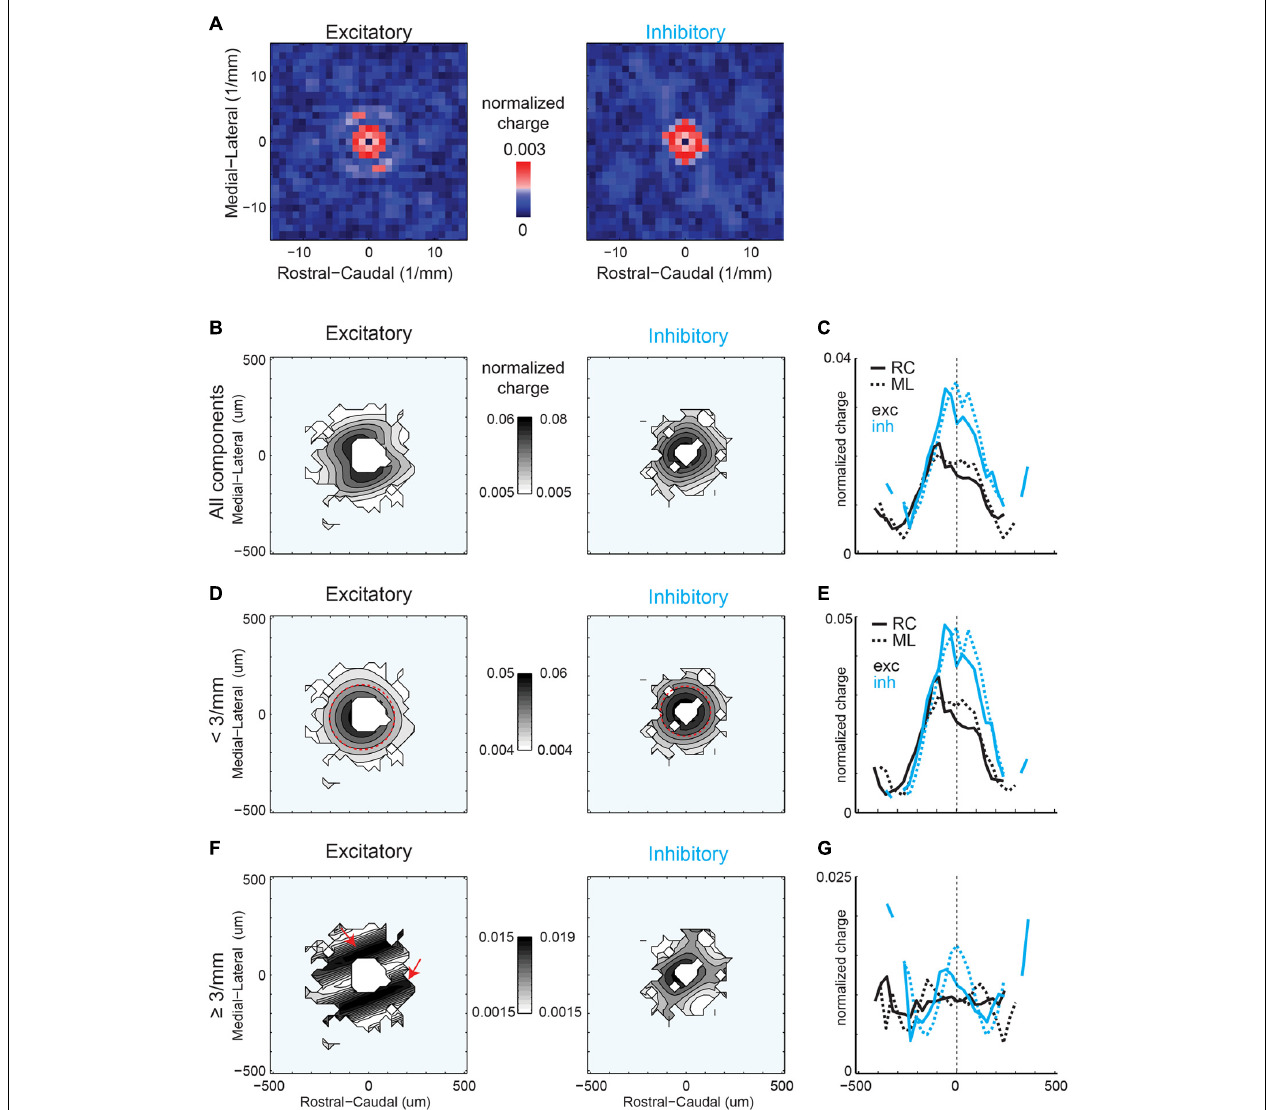
FIGURE 8 | (A) Spatial frequency anisotropy for mean strength demonstrates significant patchiness in the ML (isofrequency) direction for excitatory inputs, but symmetry amongst the significant frequency components for inhibitory inputs. (B) Reconstruction of spatial maps using only the significant frequency components (red pixels in A ). (C) Marginals in the RC and ML direction. (D,E) Reconstruction and